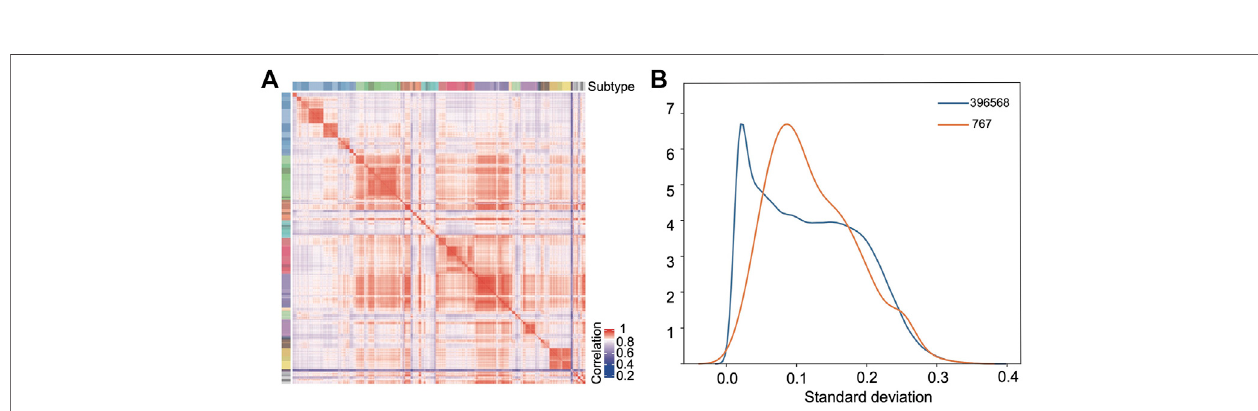
FIGURE 3 | Selected features show strong classi fi cation capability. (A) Pearson correlation heatmap based on the selected probes among the samples in the training set. (B) Distribution density curves of the standard deviations of all the probes (blue) after preprocessing and the selected 767 probes (orange).